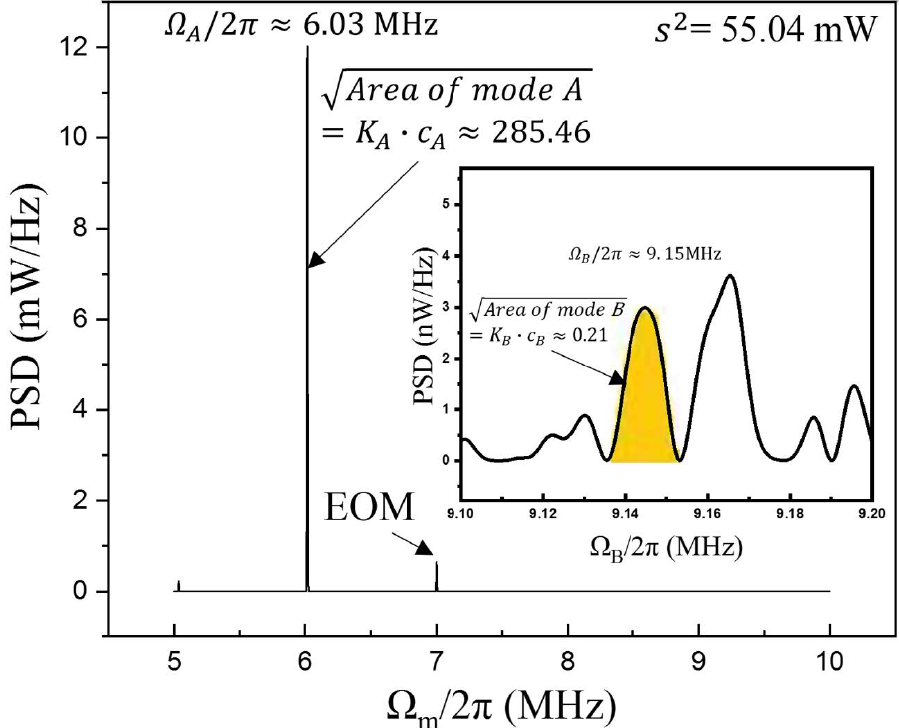
Figure A1. Power spectrum of transmitted light ( s 2 = 55.04 mW) obtained by the spectrometer, with K A · c A marked. Insert: Power spectrum at mechanical mode B after enlarging the vertical coordinate, with K B · c B marked.